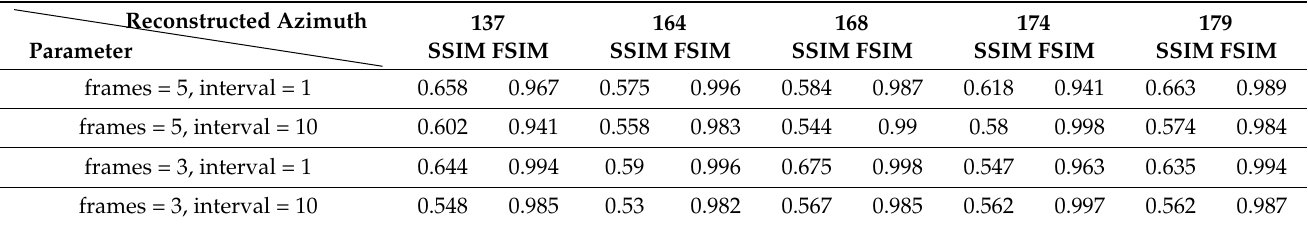
Table 3. Similarity calculation of T72 reconstruction